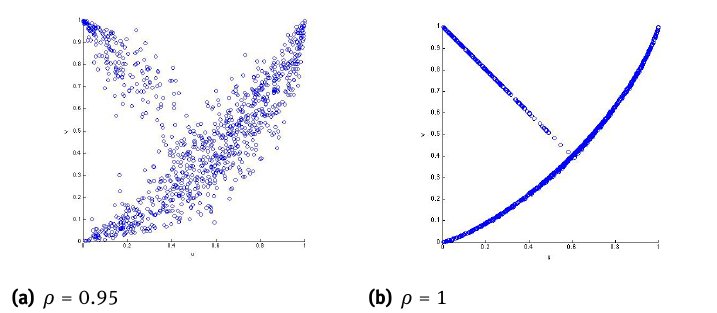
Figure 1: Copula between a Brownian motion and Brownian motion correlated to the refection of the first one with a correlation ρ = 0.95 and in the degenerated case ρ = 1 at time t = 1 and a barrier h = 2 , which is the copula of Proposition 1.